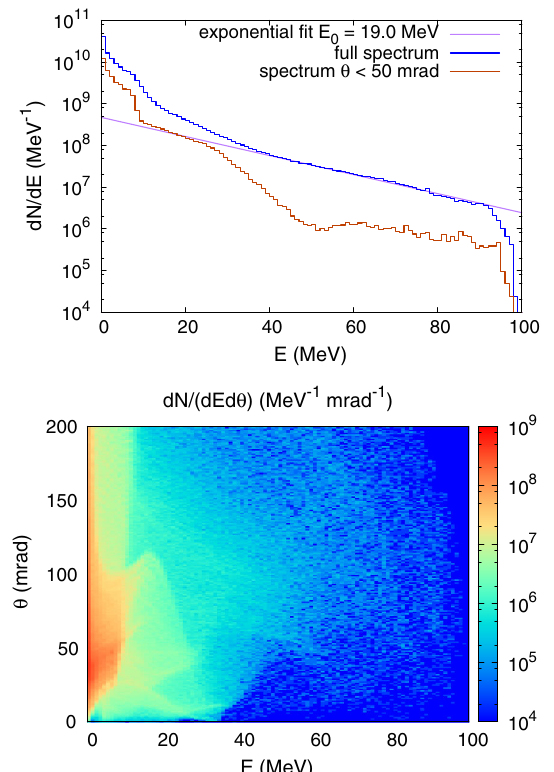
FIG. 3. Upper frame: Plot in a logarithmic scale of the proton initial energy spectrum (blue line) and after an angular selection (cid:7) < 50 mrad (light brown line) for the target with critical density (MVA) with P ¼ 155 TW and a ¼ 19 . Lower frame: Initial energy-angle distribution of the bunch in a logarithmic color